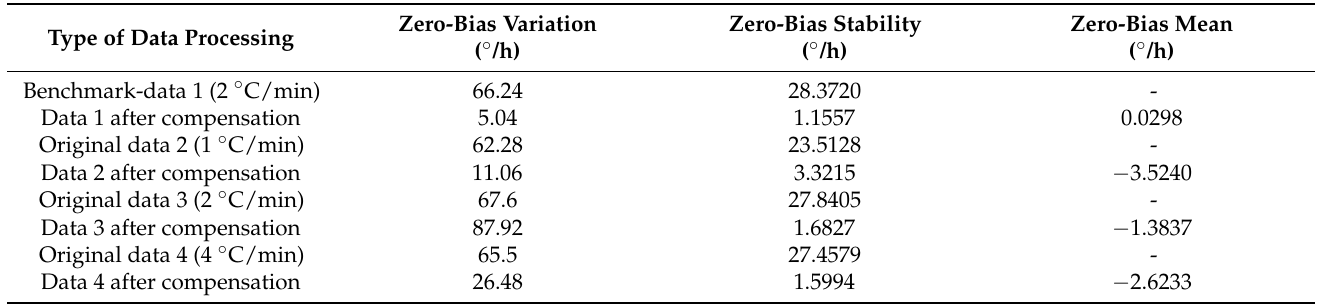
Table 3. Determine the regression equation with data 1, and use the regression equation to compensate for the effect comparison of other